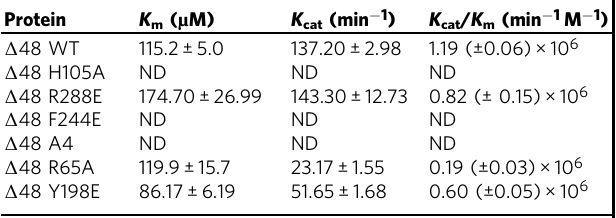
Table 2 Phosphatase activity of PGAM5 and its oligomerization-de fi cient mutants